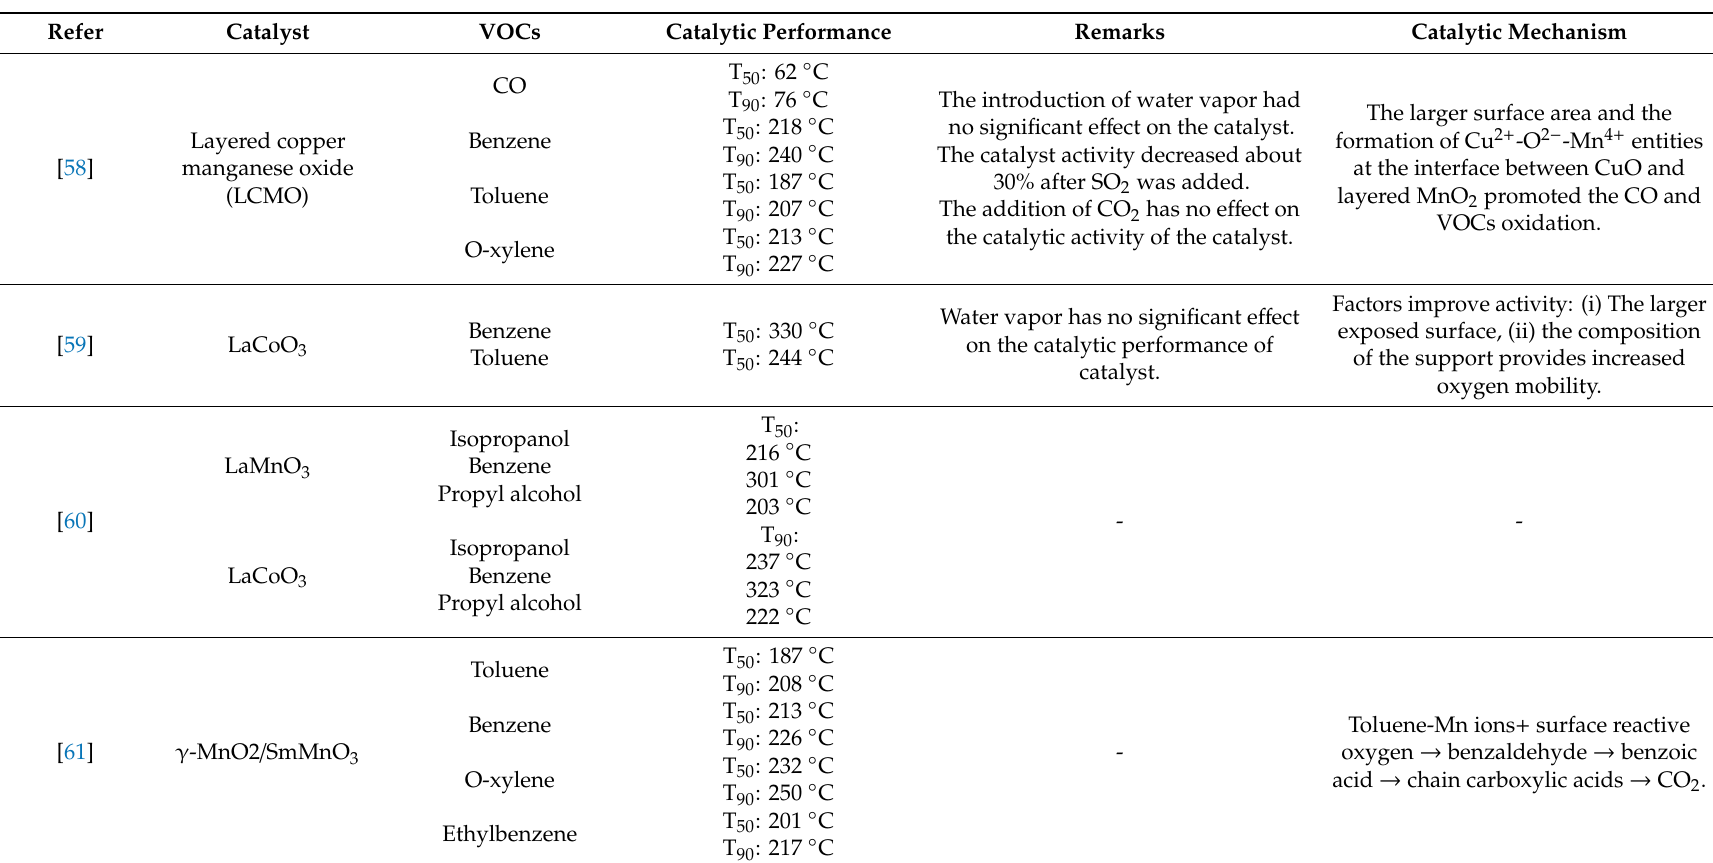
Table 7. Perovskite catalysts for catalytic combustion of